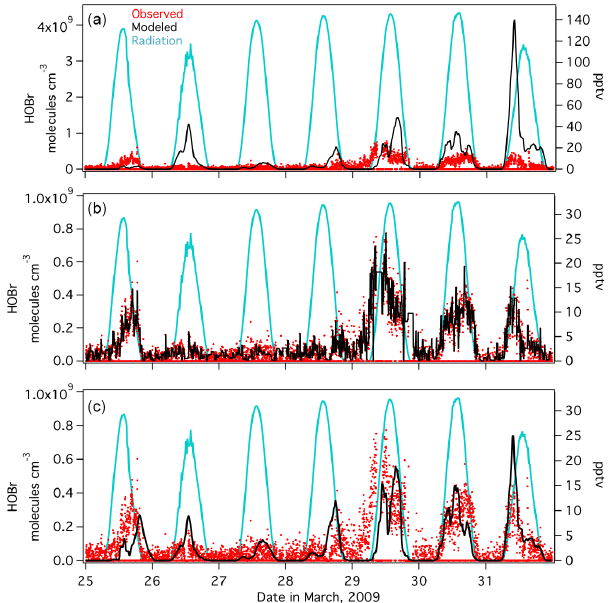
Figure 2. Simulated (black trace) versus observed (red markers) HOBr mixing ratios shown for three different versions of the model: (a) HOBr unconstrained and allowed to freely evolve with a con- stant surface deposition term as described in the Methods, (b) HOBr constrained to observations, (c) HOBr unconstrained but with a variable surface deposition that is enhanced during higher wind speeds. Simulated (unconstrained) output in (a, c) are smoothed by hourly averaging. Radiation is shown as the cyan trace as a refer- ence. Time is expressed in Alaska standard